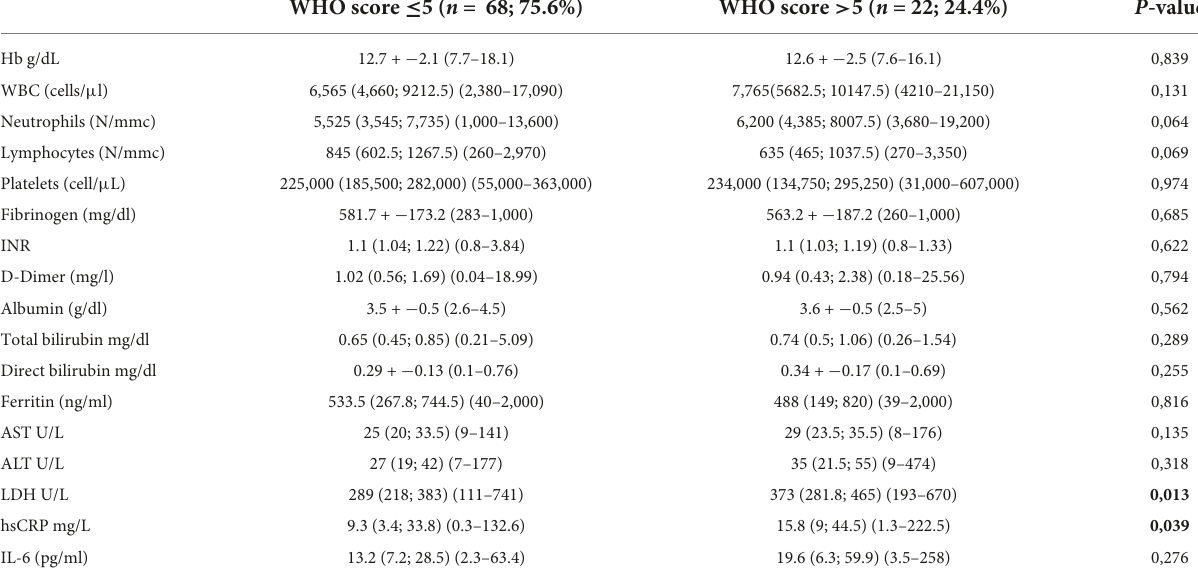
Data are expressed as mean ± standard deviation (range); median (25th; 75th percentile) (range) or absolute frequency (percentage). Hb, haemoglobin; WBC, white blood cells; INR, international normalized ratio; AST, aspartate transaminase; ALT, alanine transaminase; LDH, Lactate dehydrogenase; hsCRP, high sensitive C-reactive protein; IL-6, interleukin-6. Bold